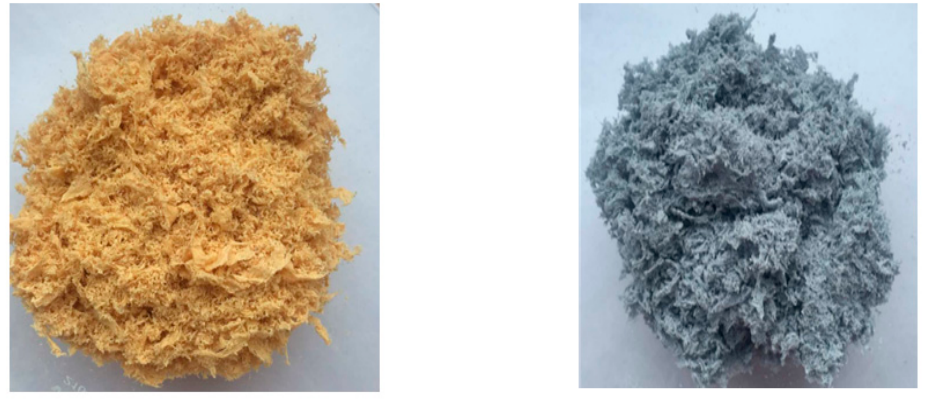
Figure 3. Shaving waste samples 1 and